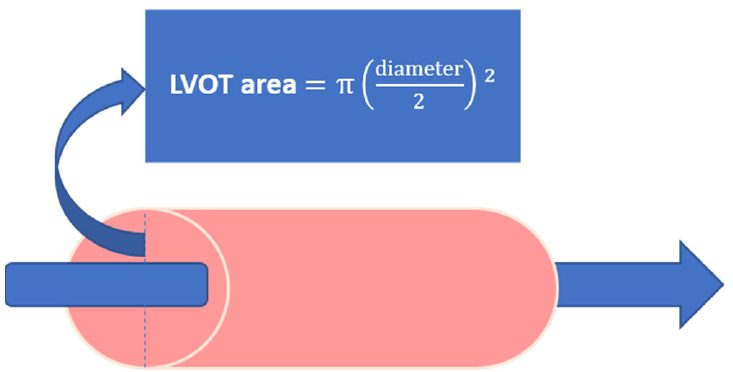
Figure 2. LVOT area calculation based on the diameter of the LVOT. Abbreviations: LVOT, left ventricular outflow tract.